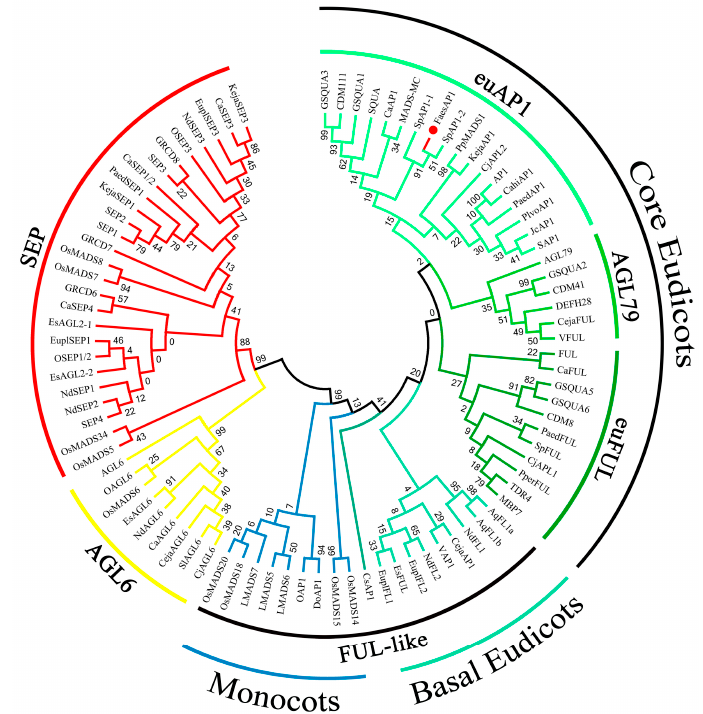
Figure 2. Phylogenetic analysis of FaesAP1 and other AP1/SEP/AGL6 superclade of MADS-box proteins from different clades of angiosperms.